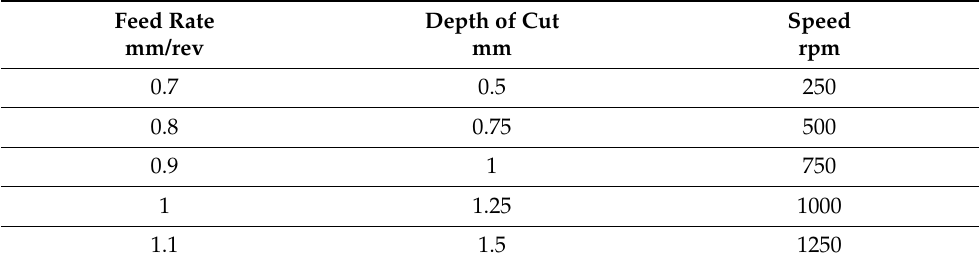
Table 1. Machining parameters for turning